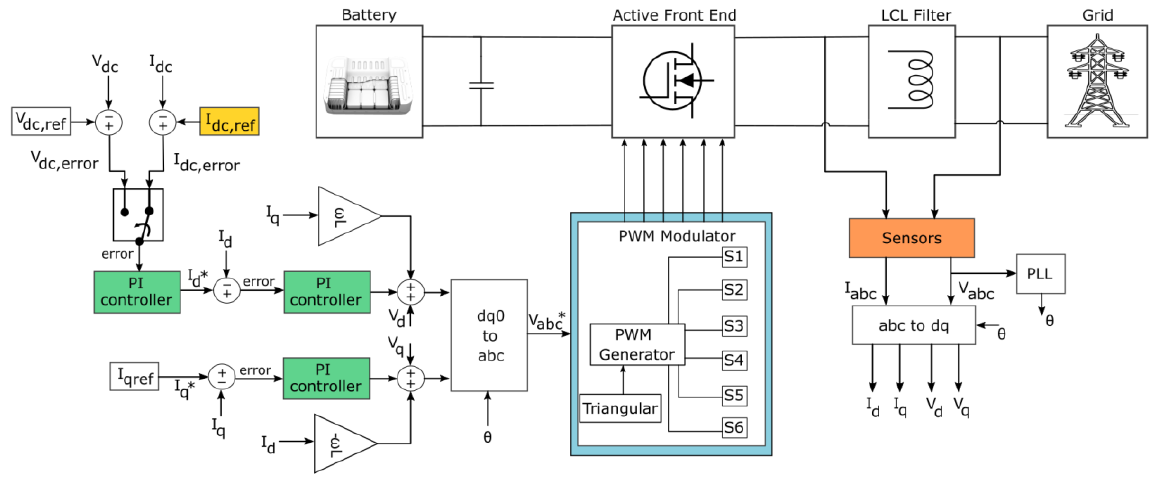
Figure 3. Low-level controller of the off-board charger.